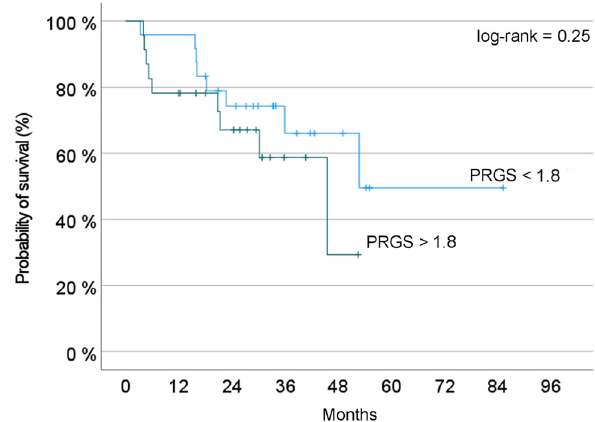
Figure 3: Probability of overall survival depending on PRGS. Two groups of patients are compared: Blue curve = patients with a PRGS inferior to the median value of the cohort; red curve: Patients withaPRGSsuperiortothisvalue,suggestingapoorerprognosis.In this small cohort of patients, the difference observed did not reach statistical signi fi cance (log-rank test,